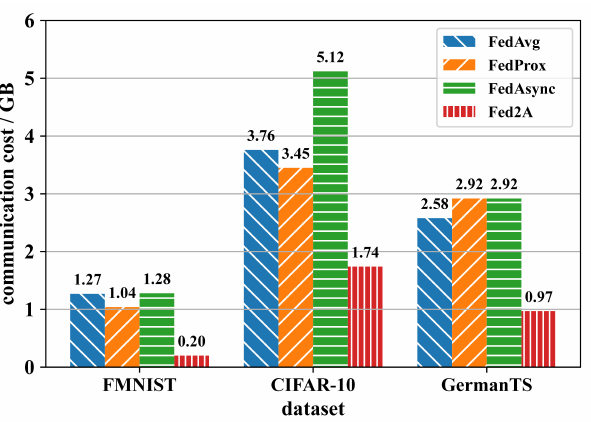
Figure 7. The communication cost of Fed2A compared with the baselines in the three datasets. Note that since FedProx and FedAsync have not reached the target accuracy for GermanTS, the correspond- ing costs are the overall costs of the total 300 rounds, i.e., 2.92